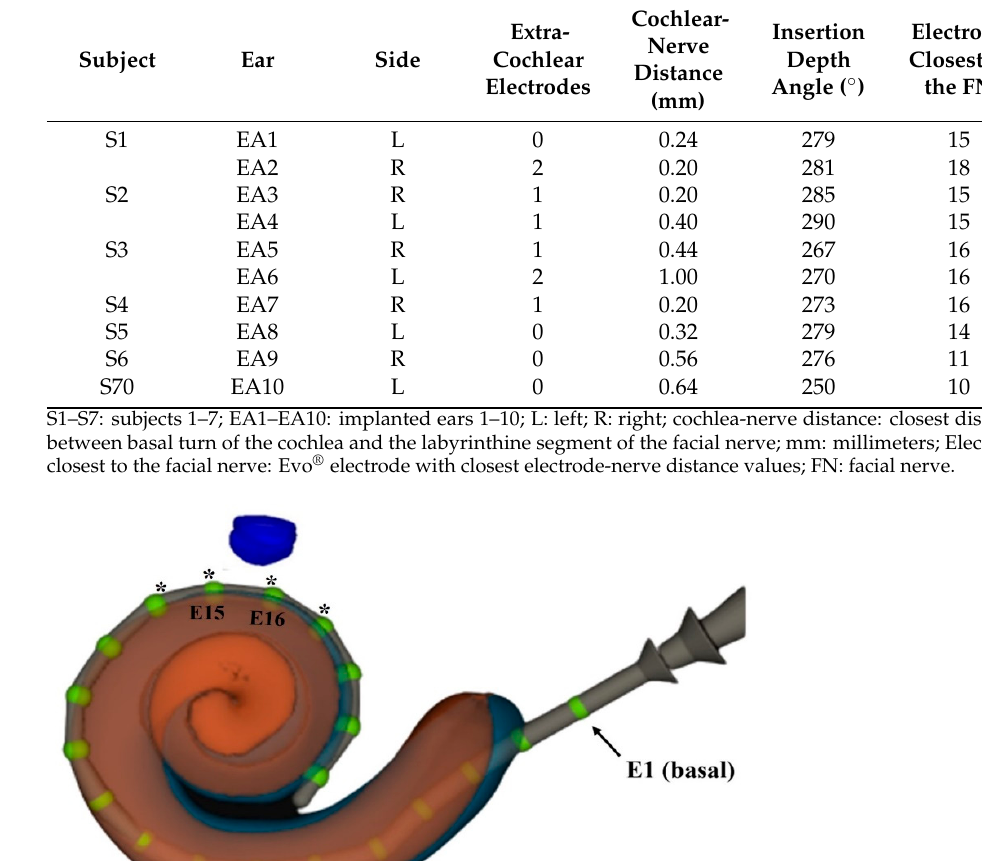
Table 4. Intra-cochlear electrodes placement, cochlea-nerve and electrode-nerve distances estimation of the subjects.